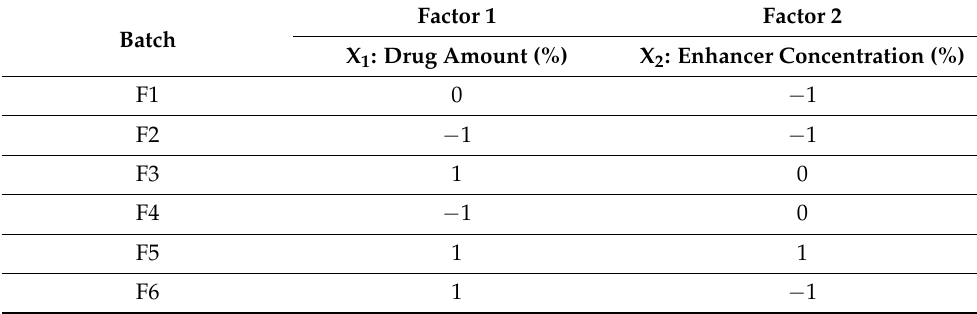
Table 2. Concentrations of various factors are used for